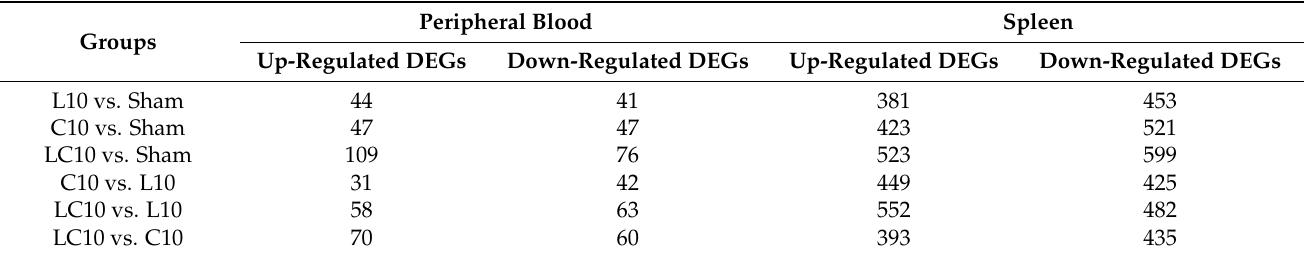
Table 1. The number of differentially expressed genes (DEGs) after compound microwave exposure in peripheral blood and the spleen.